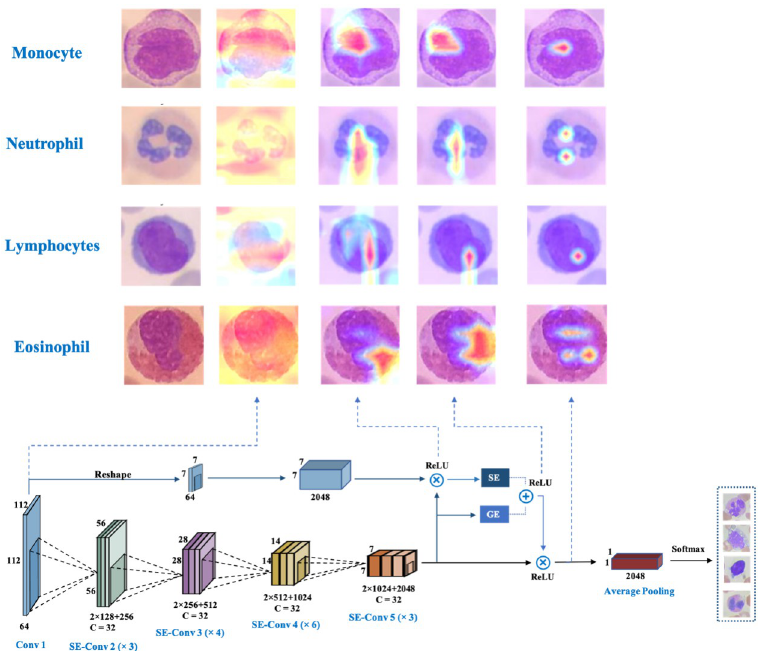
Fig 13. WBC-AMNet visualization analysis of attention to different feature